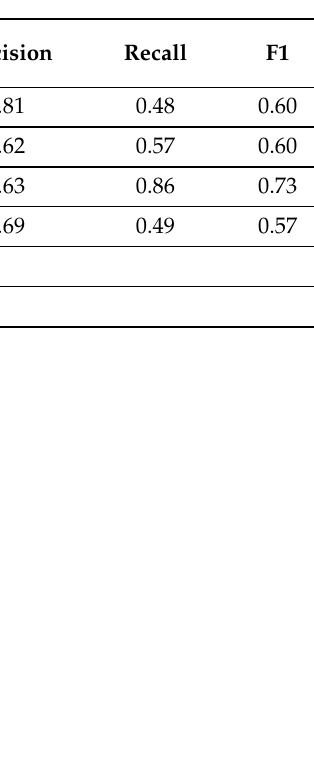
Figure 17. The training behavior of the model based on InceptionResNetV2. Table 10. InceptionResNetV2.